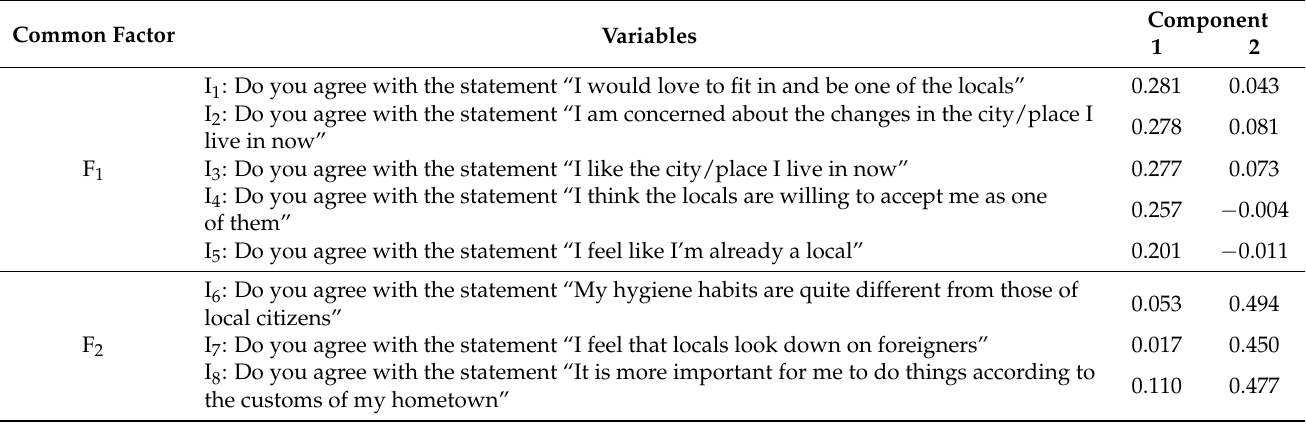
Table 1. Component score coefficient